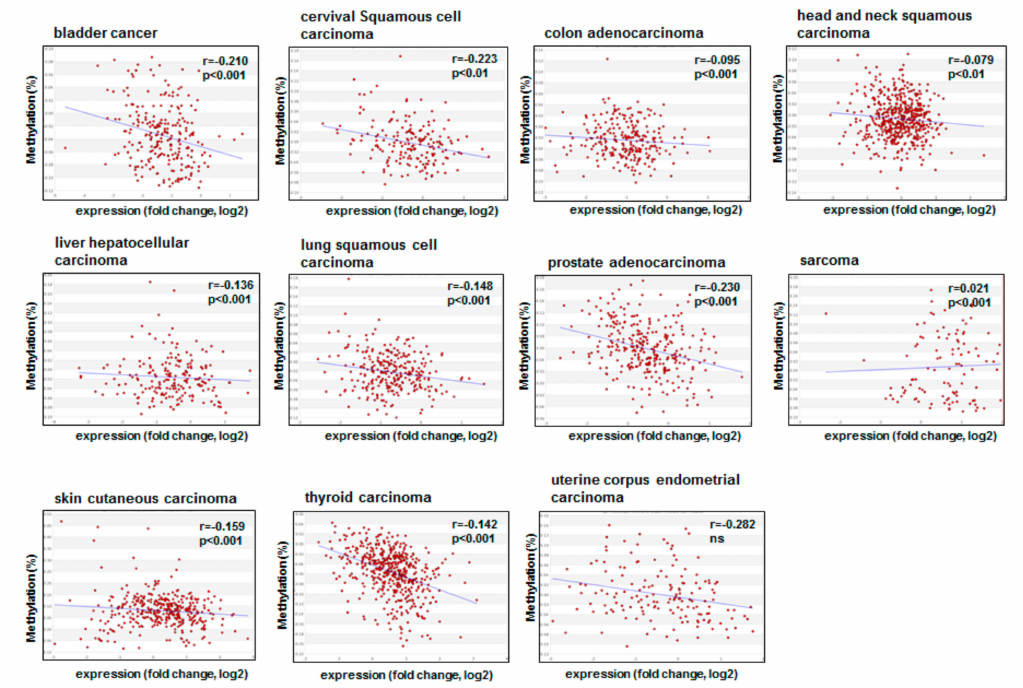
Figure 2. Comparison of promoter DNA methylation level and mRNA expression in tumor samples in a panel of di ff erent tumor types. ß values for methylation are between 0 and 1: 0—unmethylated and 1—fully methylated. Data were taken from the MethHC database (http: // methhc.mbc.nctu.edu.tw / ) for p21 cip1 / waf1 (Nm-000389). r , correlation coe ffi